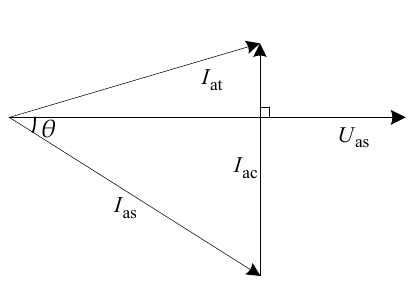
Figure 5. The vector diagram.